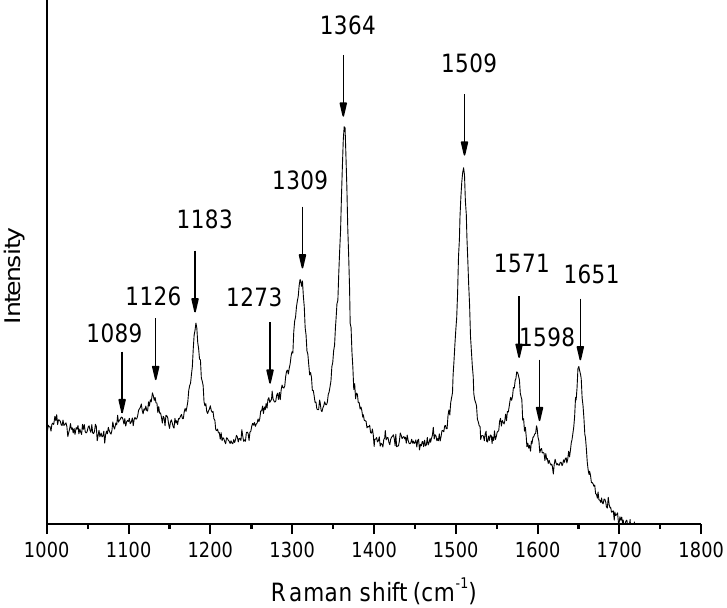
Figure 3. Raman spectrum of 10 − 3 M R6G